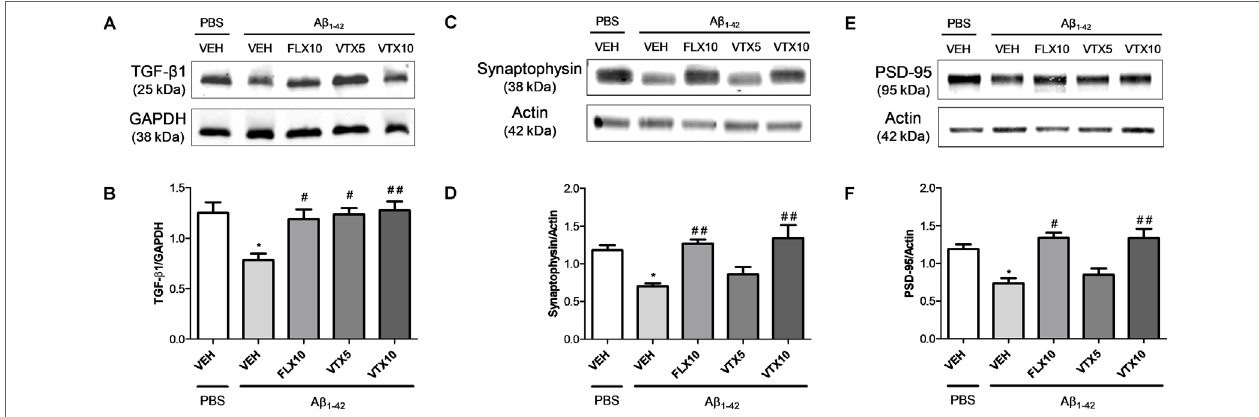
FIGURE 5 | Fluoxetine and vortioxetine rescue TGF- β 1, synaptophysin, and PSD-95 levels in A β 1-42 -treated mice. Effects induced by i.c.v. administration of A β 1-42 (A β 1-42 + VEH) in absence or presence of FLX10, VTX5, or VTX10 on TGF- β 1, synaptophysin and PSD-95 levels examined by western blot. (A) Representative immunoblots of active TGF- β 1 (about 25 kDa) in total protein extracts from hippocampus tissues. (B) Histograms refer to the means ± SEM of the densitometric values of active TGF- β 1 bands normalized against GAPDH. Each experiment was repeated four times. * p < 0.05 vs. PBS + VEH, # p < 0.05 vs. A β 1-42 + VEH, ## p < 0.01 vs. A β 1-42 + VEH; F (4,15) = 5.91 for (B) . (C) Representative immunoblots of synaptophysin (about 38 kDa) in total protein extracts from hippocampus tissues. (D) Histograms refer to the means ± SEM of the densitometric values of synaptophysin bands normalized against actin. Each experiment was repeated four times. * p < 0.05 vs. PBS + VEH, ## p < 0.01 vs. A β 1-42 + VEH; F (4,17) = 7.91 for (D) . (E) Representative immunoblots of PSD-95 (about 95 kDa) in total protein extracts from hippocampus tissues. (D) Histograms refer to the means ± SEM of the densitometric values of PSD-95 bands normalized against actin. Each experiment was repeated four times. * p < 0.05 vs. PBS + VEH, # p < 0.05 vs. A β 1-42 + VEH, ## p < 0.01 vs. A β 1-42 + VEH; F (4,17) = 8.21 for (F)